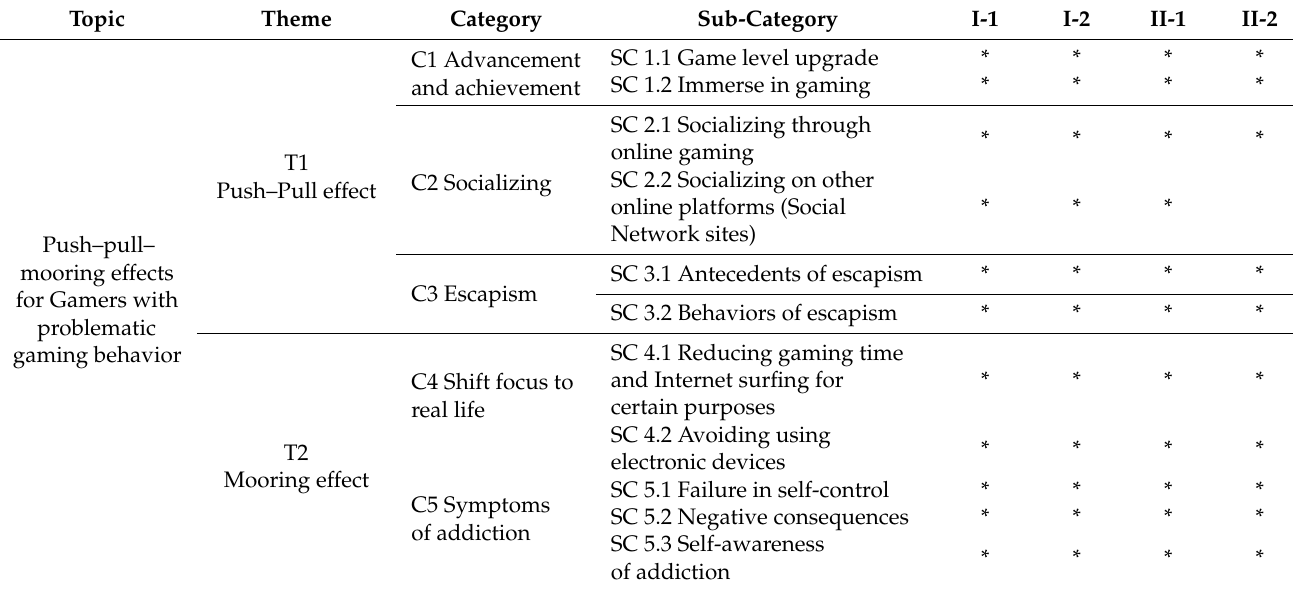
Table 3. The second cycle content analysis and four